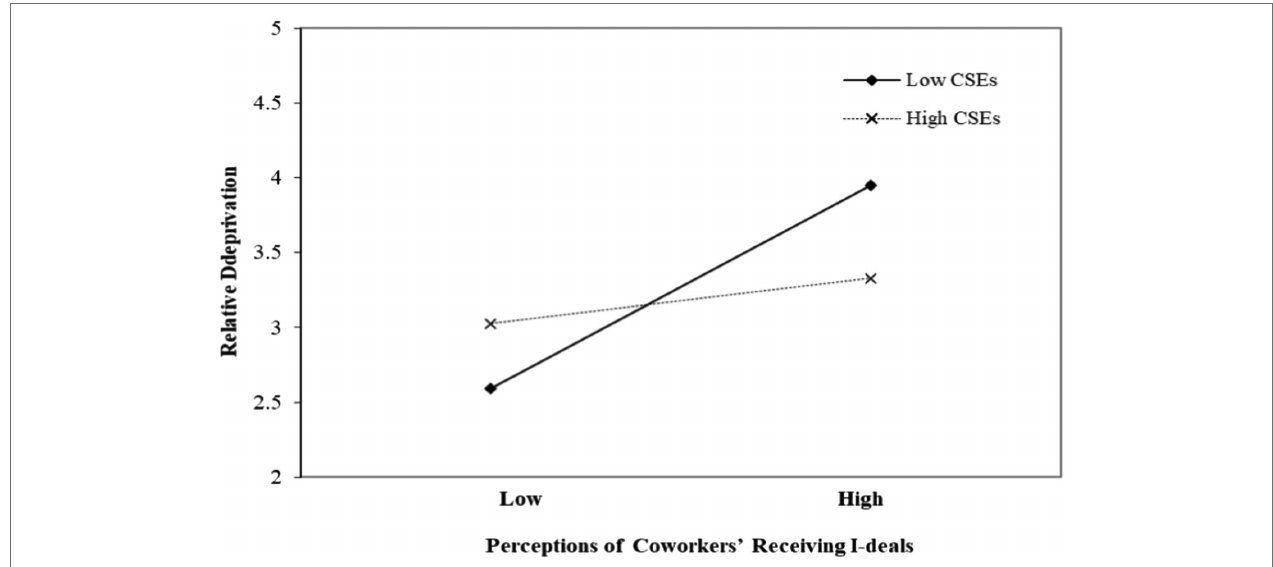
FIGURE 2 | The moderating effect of core self-evaluations (CSEs) on the relationship between perceptions of coworkers’ receiving i-deals and relative deprivation.